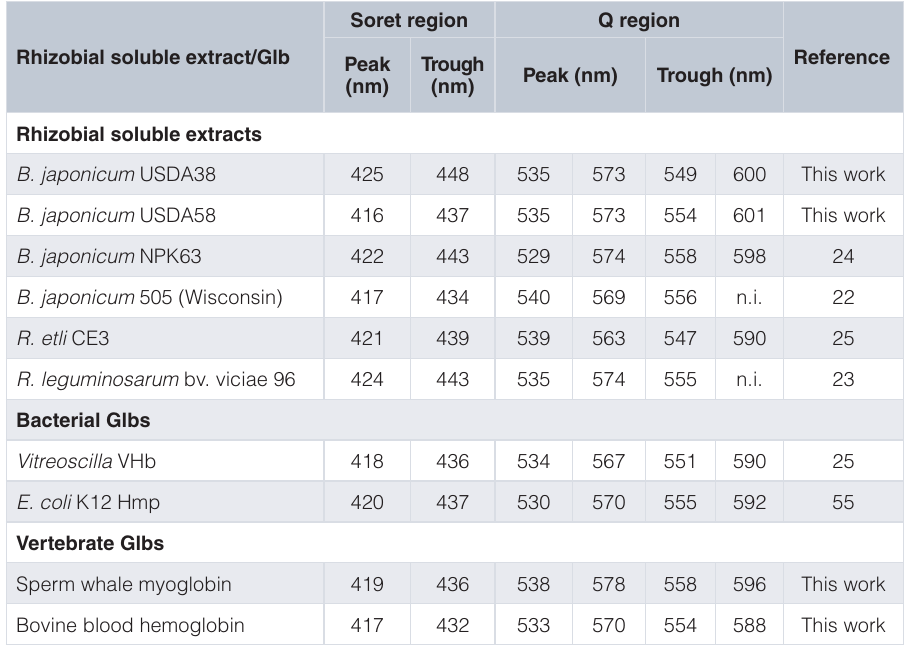
Table 3. Absorption peaks and troughs in the Soret and Q regions from the (dithionite reduced + CO minus dithionite reduced) differential spectra of rhizobial soluble extracts and other bacterial and vertebrate Glbs.